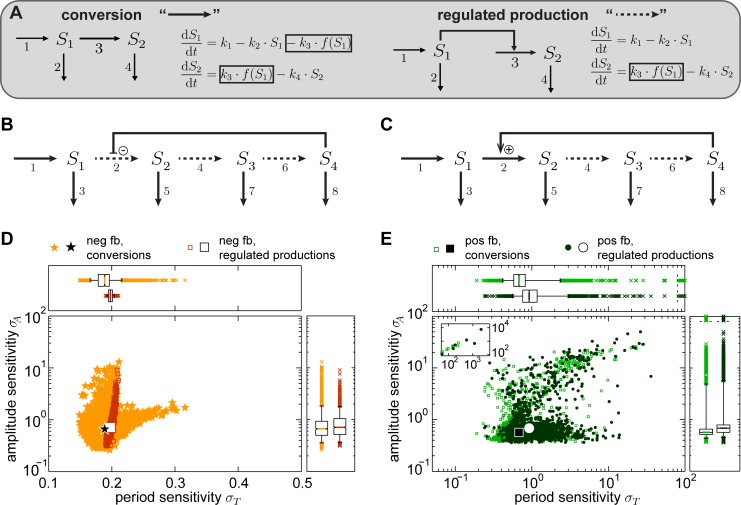
Impact of mass conservation properties on the sensitivity of the chain model.A: Schemes and equations of a mass conversion and a regulated production rate (reaction 3). For a mass conversion, the reaction rate occurs in the equation of the source species as well as of the product species (highlighted by boxes). For a regulated production rate, only the equation of the product species is affected by the reaction (highlighted by box). Regulated production rates are in the following represented by dashed arrows, mass conversions by solid lines. B, C: Schemes of the chain model with negative (B) or positive (C) feedback in that mass conversion reactions 2, 4, 6 or 4, 6, respectively, have been replaced by regulated production rates. D, E: Sensitivities for the negative (D, neg fb, red squares) and positive (E, pos fb, dark green dots) feedback chain model as shown in B and C, respectively. For comparison, sensitivities considering mass conversion reaction rates only are shown (data from Fig 2D).